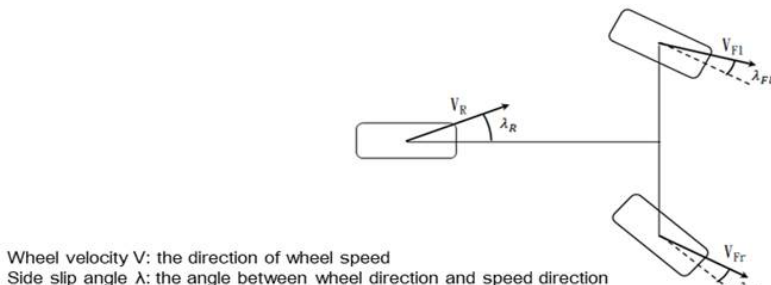
Figure 21. Tire slip